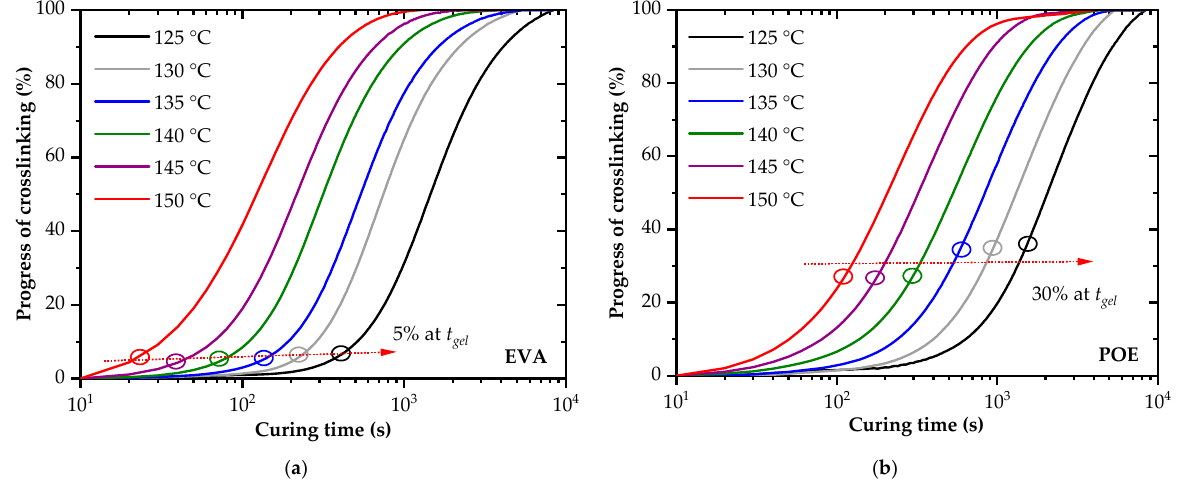
Figure 6. Progress of crosslinking of EVA ( a ) and POE ( b ) as a function of curing temperature and time ( t gel …gelation time).